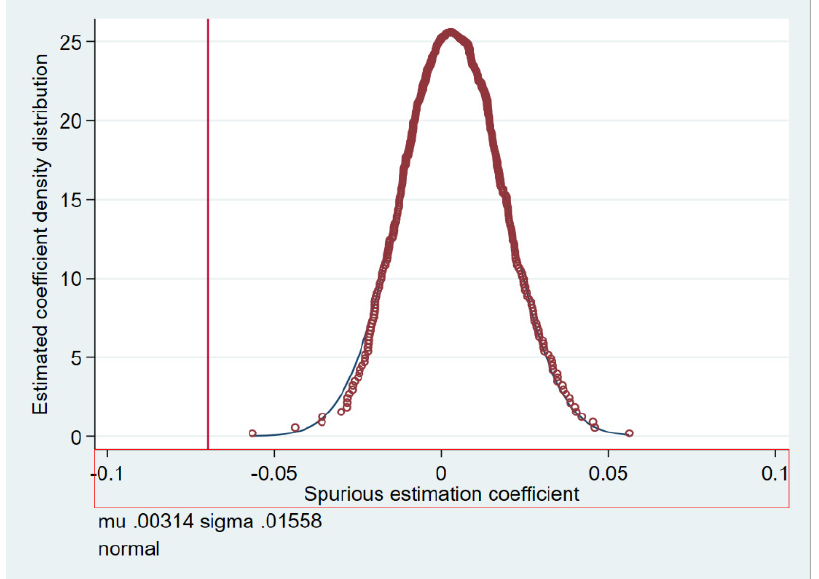
Figure 3. Placebo